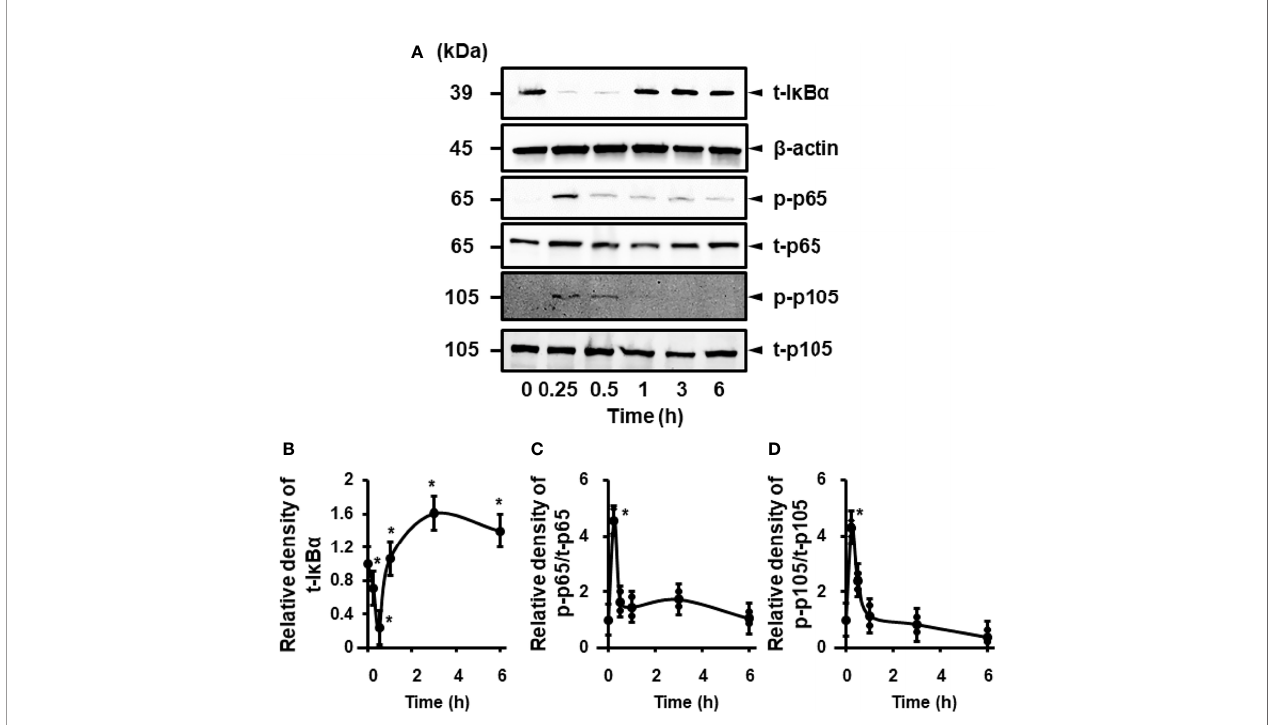
FIGURE 3 | IL-1 b -mediated activation of NF- k B. (A) Representative western blotting results of levels of total I k B a (t-I k B a ), phosphorylated p65 (p-p65), total p65 (t-p65), phosphorylated p105 (p-p105), and total p105 (t-p105) in canine cardiac fi broblasts treated with IL-1 b (100 pM). b -actin was used as an internal standard. Time-dependent changes of levels of t-I k B a , p-p65 and p-p105 were observed. Relative levels of t-I k B a (B) , [p-p65]/[t-p65] (C) , and [p-p105]/[t-p105] (D) in IL-1 b - stimulated fi broblasts compared to the levels at 0h. Results have been represented as mean ± SE from biological triplicates. *P <0.05.